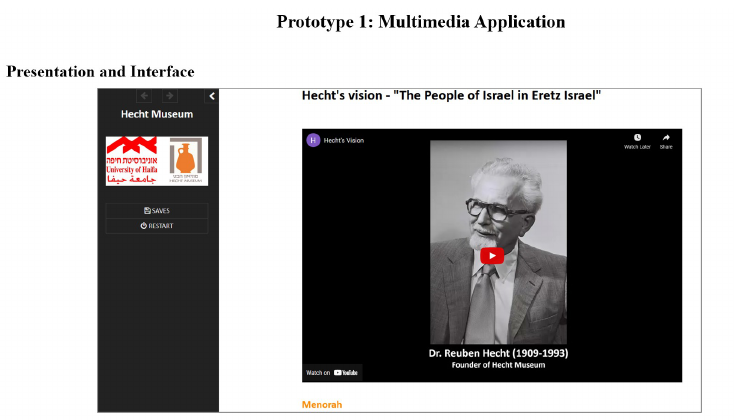
Figure 13. A screenshot of the web-based application with the introductory